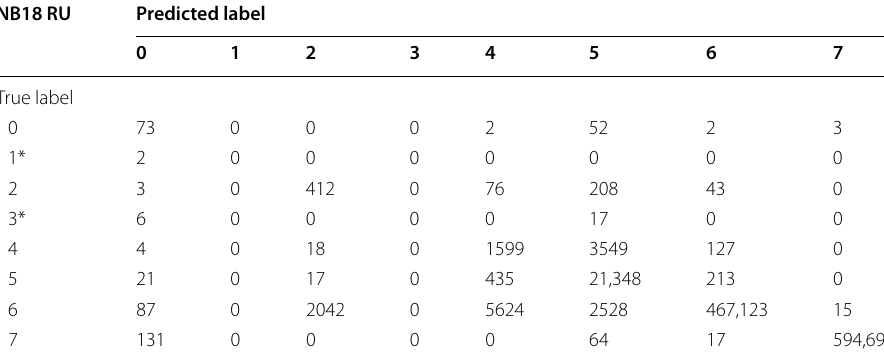
Table 32 Confusion matrix: NB18 RU